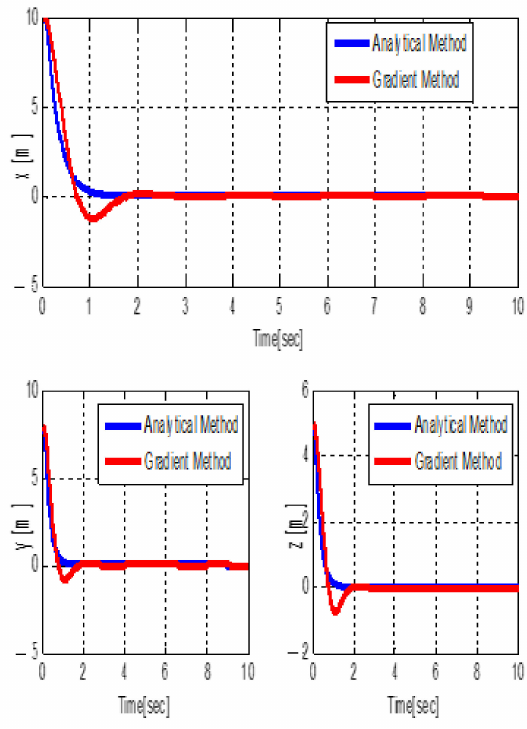
Figure 7. Stabilization of x 0 , y 0 , z 0 .